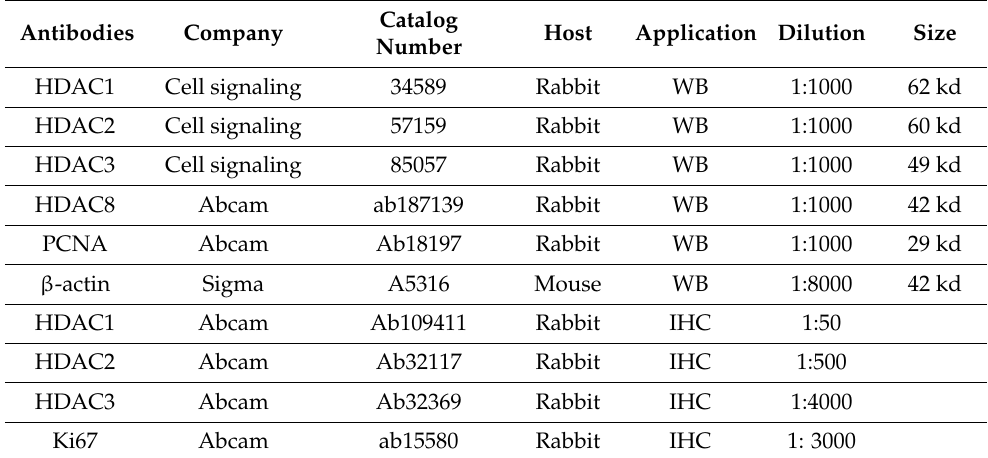
Table 1. Antibodies used in this